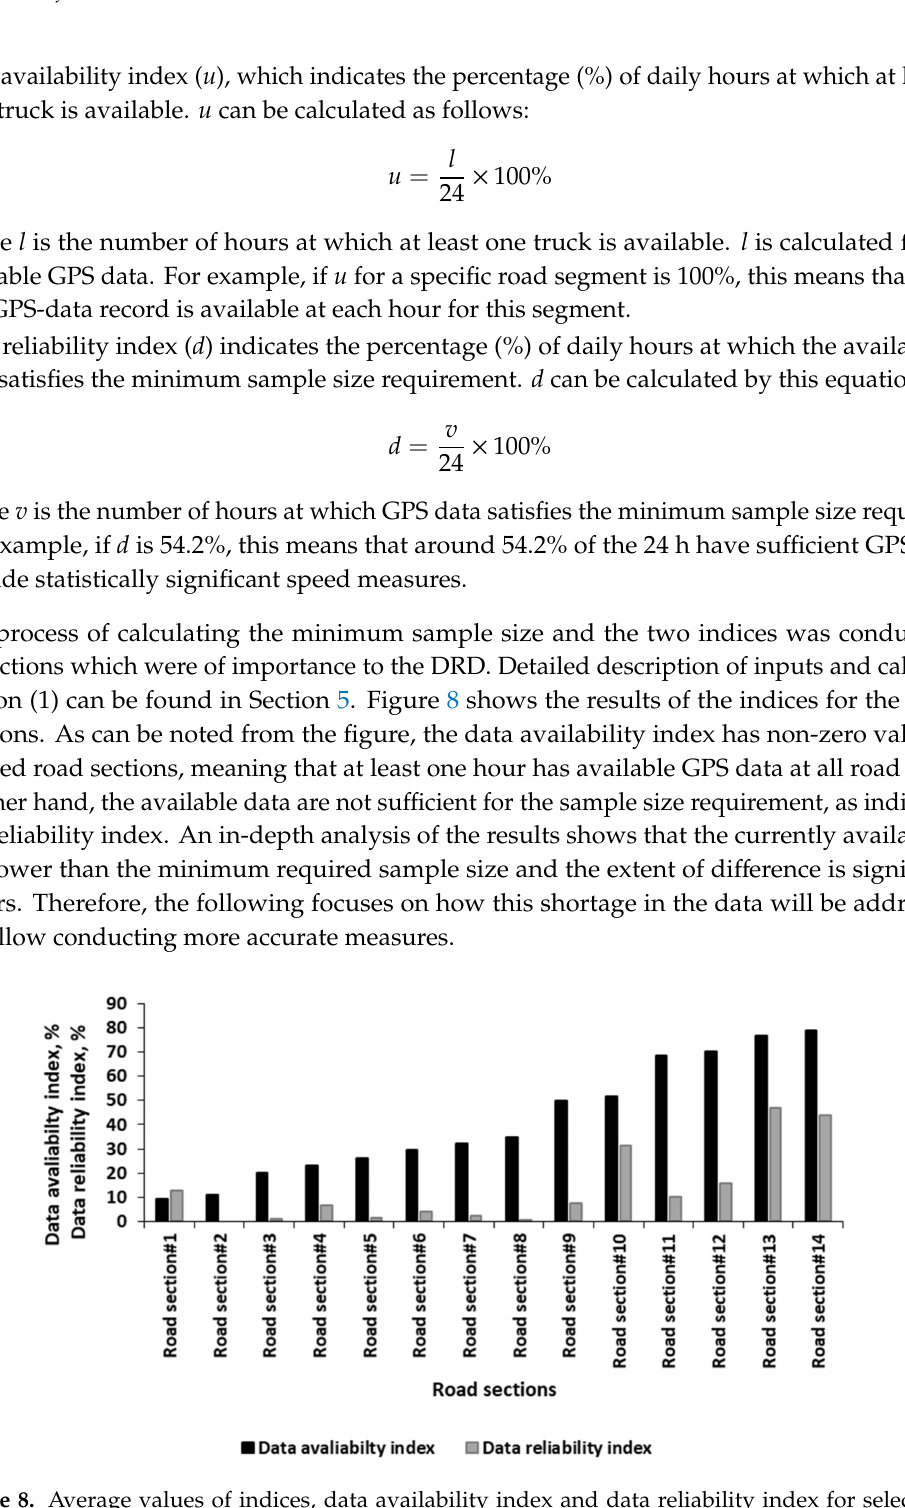
Figure 8. Average values of indices, data availability index and data reliability index for selected road